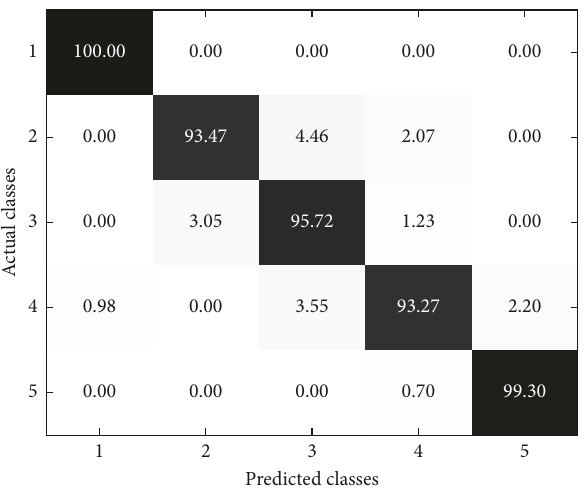
Figure 5: The confusion matrix (%) of MKSCDL on the zenithal dataset. The labels 1–5 refer to the corresponding cloud types: 1—stratiform clouds, 2—cumuliform clouds, 3—waveform clouds, 4—cirriform clouds, and 5—clear